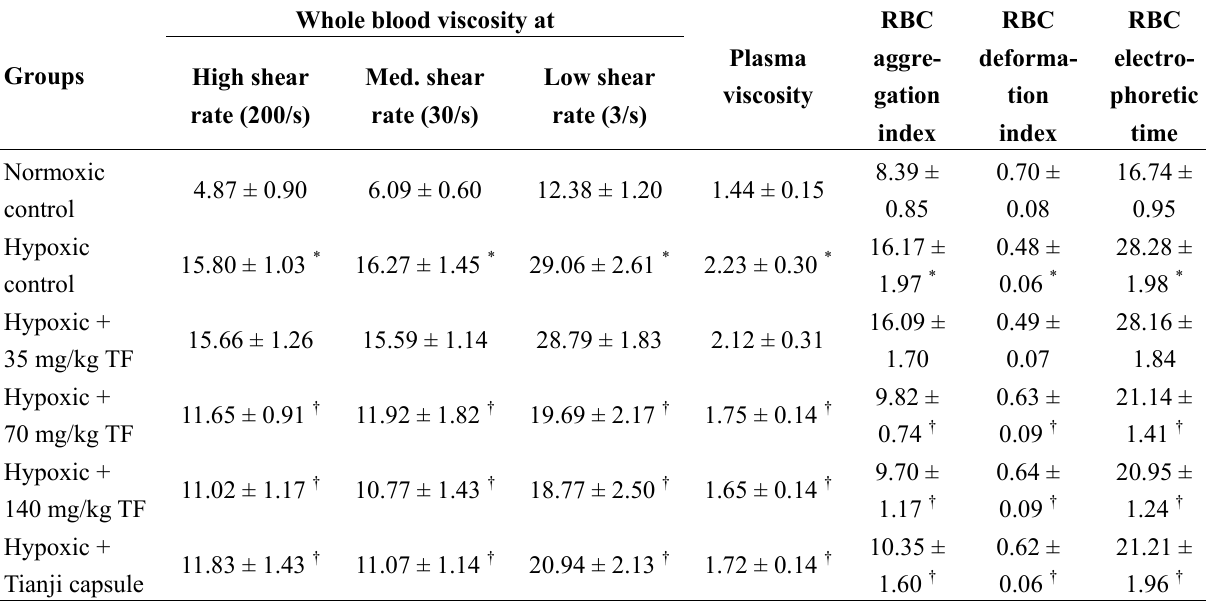
Table 2. Effect of total flavonoids of seabuckthorn on haemorheology variables in high-altitude polycythemia rats.